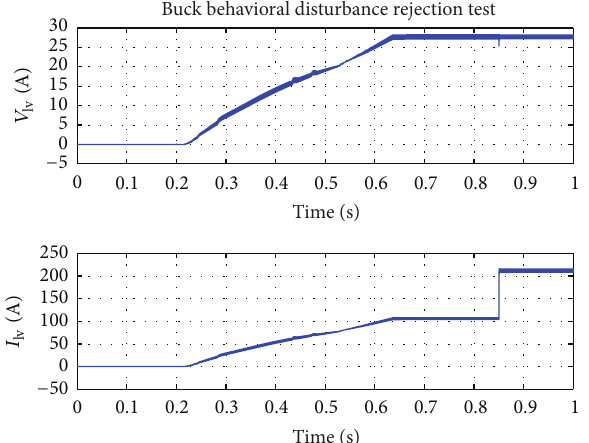
Figure 14: Boost mode test for behavioral robustness test.